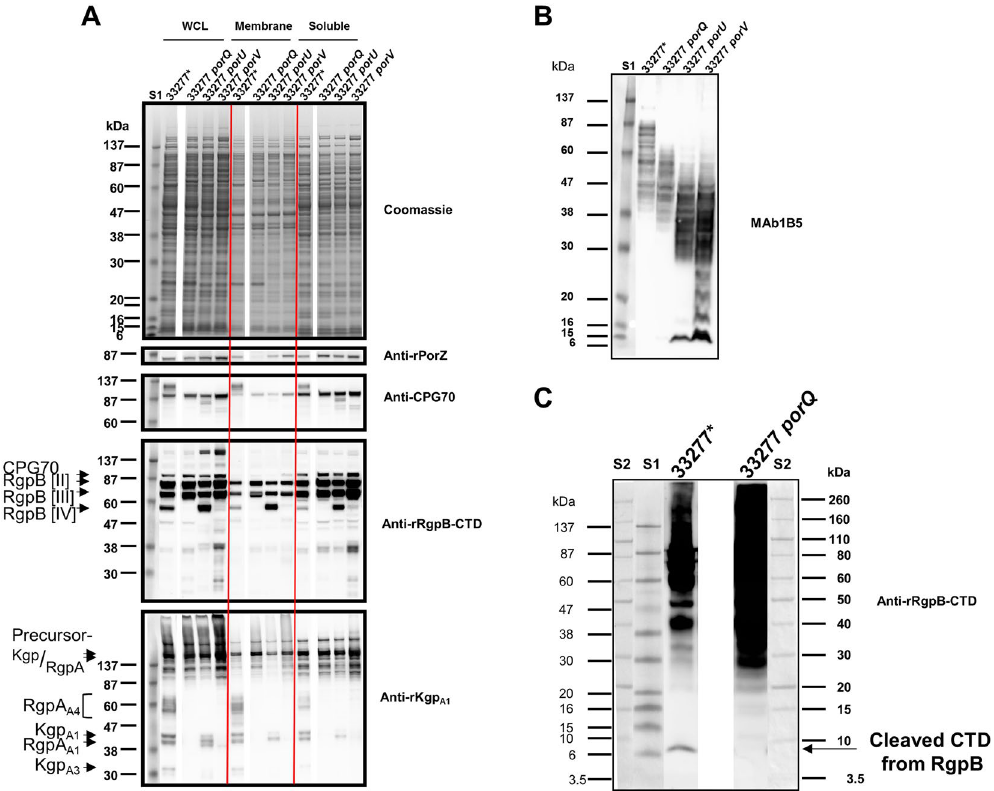
Figure 3. Characterisation of porQ mutant by Western blot. ( A ) Coomassie stained SDS PAGE and Western blots of P. gingivalis strain culture fractions. Equivalent amounts of log-phase culture fractions were compared. Mouse antisera used are shown on right hand side of respective Western blot. ( B ) Equivalent amounts of log-phase whole cell lysates subjected to MAb1B5 Western blot. ( C ) Anti-rRgpB-CTD Western blot of TCA- precipitated filtered and clarified culture fluid (CCFF, 1 ml) from indicated strains subjected to reducing SDS- PAGE using MES as running buffer. All samples were from cells grown to an OD 650nm of approximately 0.8. S1, protein standard Prestained Benchmark Protein Ladder. S2, Ponceau S stained protein standard Novex Sharp. White spaces between strain 33277 * and mutant samples represents removal of irrelevant